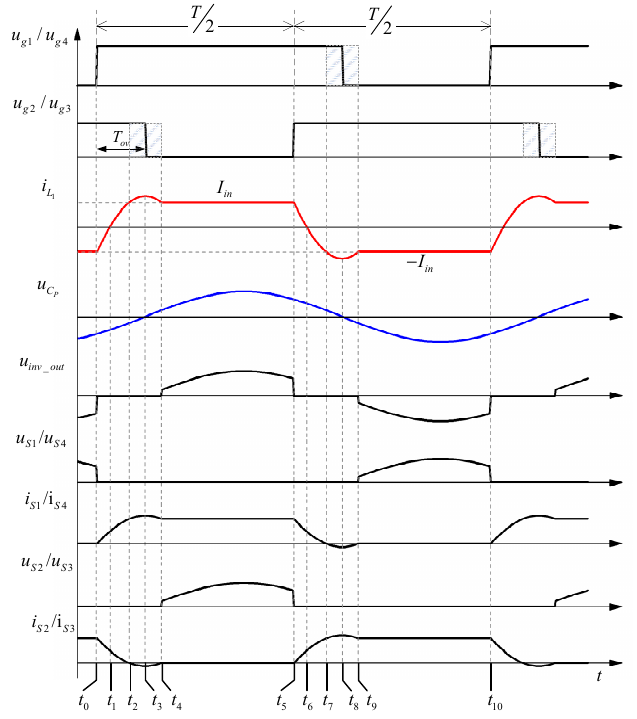
Figure 6. Steady-state waveform of the proposed system in a cycle.